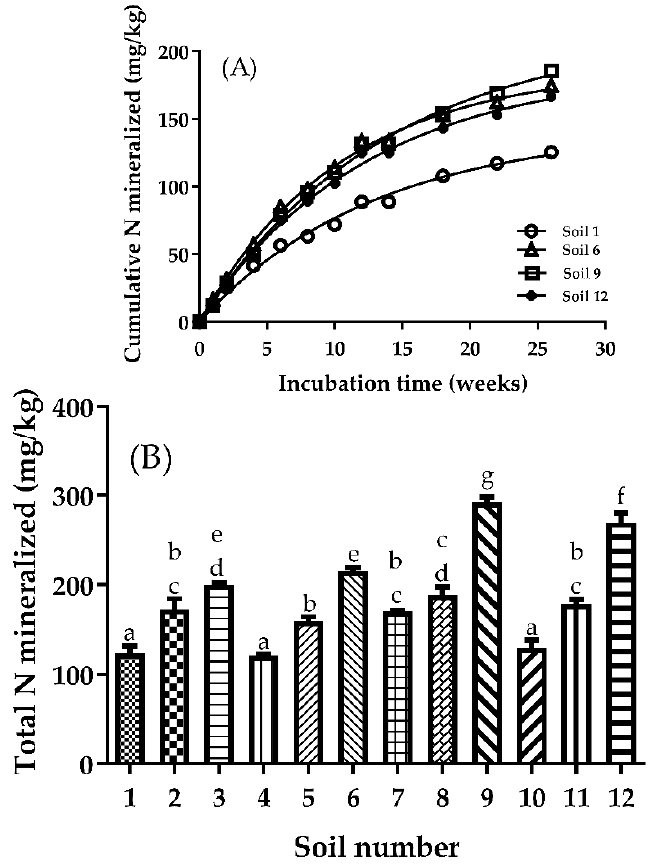
Figure 1. Cumulative amounts of N mineralized in four of the soils used in relation to incubation time ( A ), and net amounts of N mineralized in soils during incubation for 26 weeks at 25 ◦ C ( B ). Error bars represent standard error of three replicates. Bars followed by the same letter are not significantly different at p = 0.05.